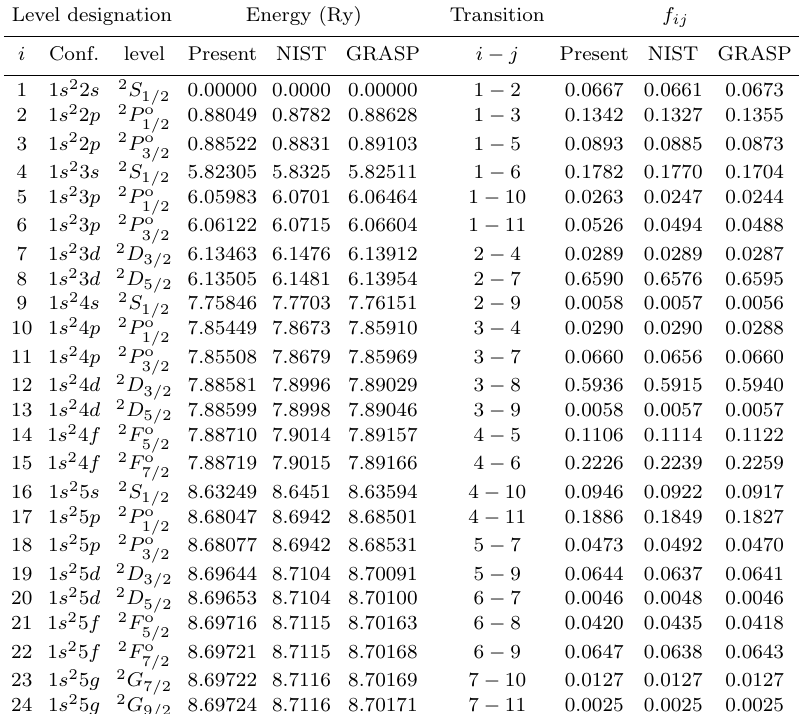
Table 1. O VI energy levels and oscillator strengths of some allowed transitions com- pared to NIST and GRASP results. Level